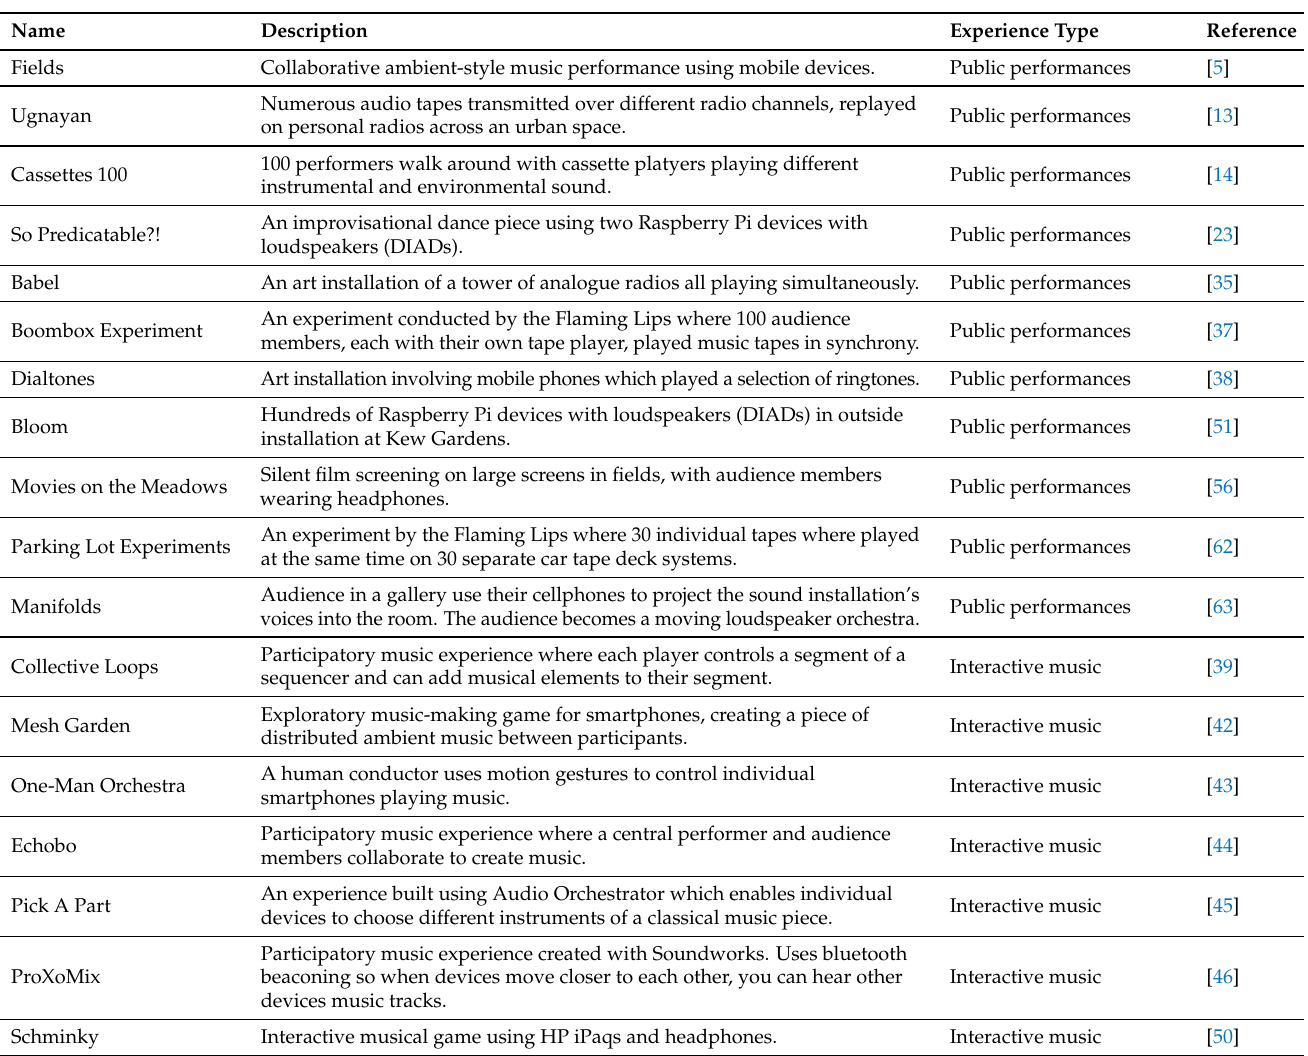
Table A2. All the individual experiences in the dataset, with descriptions, the type of experience, and the associated